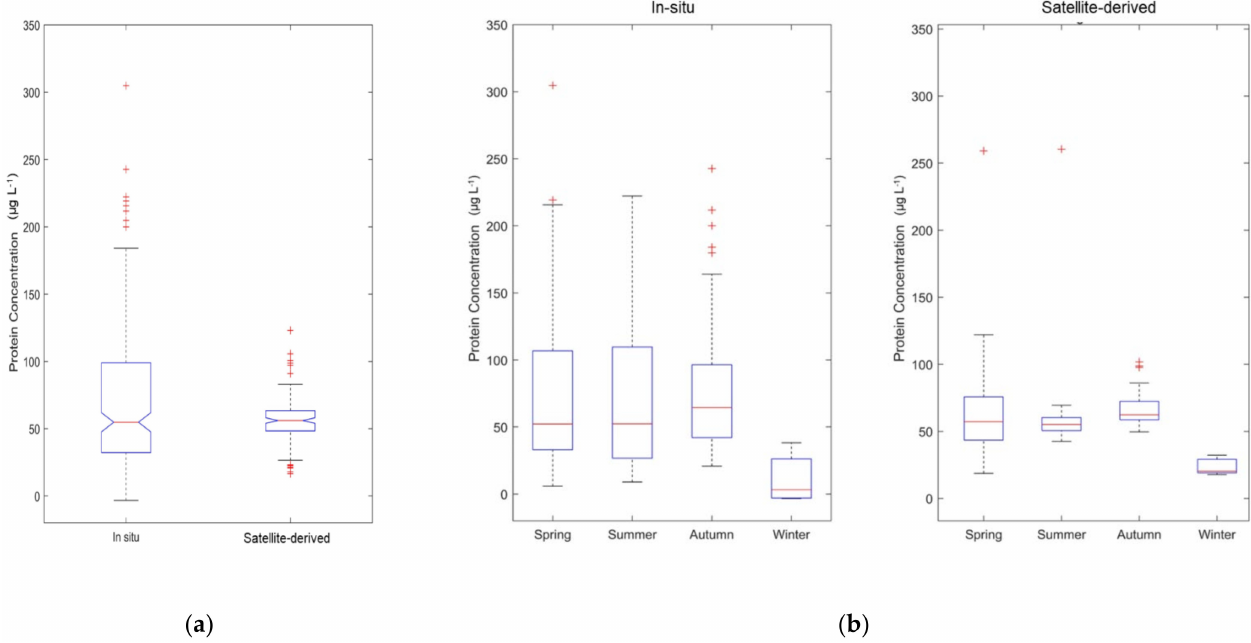
Figure 5. Boxplots comparing the field-measurements with satellite-derived based on the regional algorithm with total data ( a ) and seasonal distribution ( b